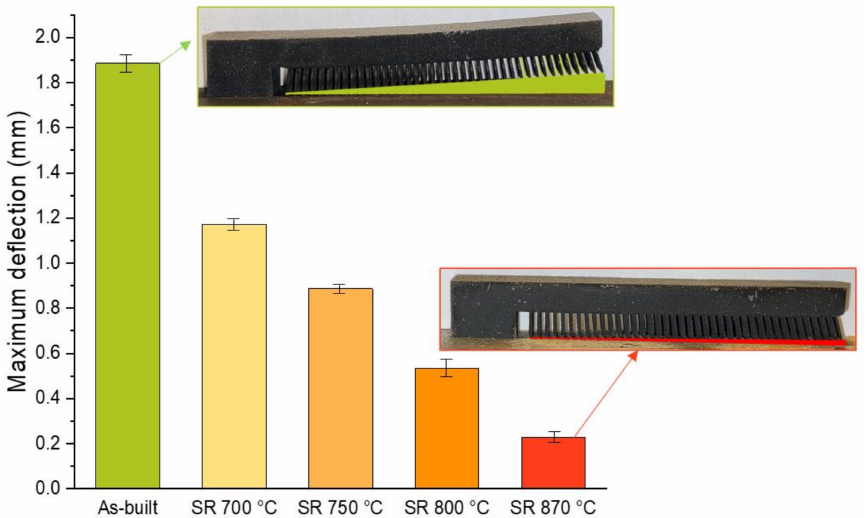
Figure 3. Cantilever maximum deflection for as-built and different SR